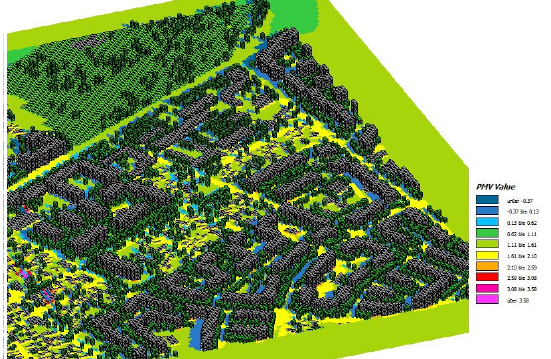
Figure 1. The simulated index of Predicted Mean Vote related